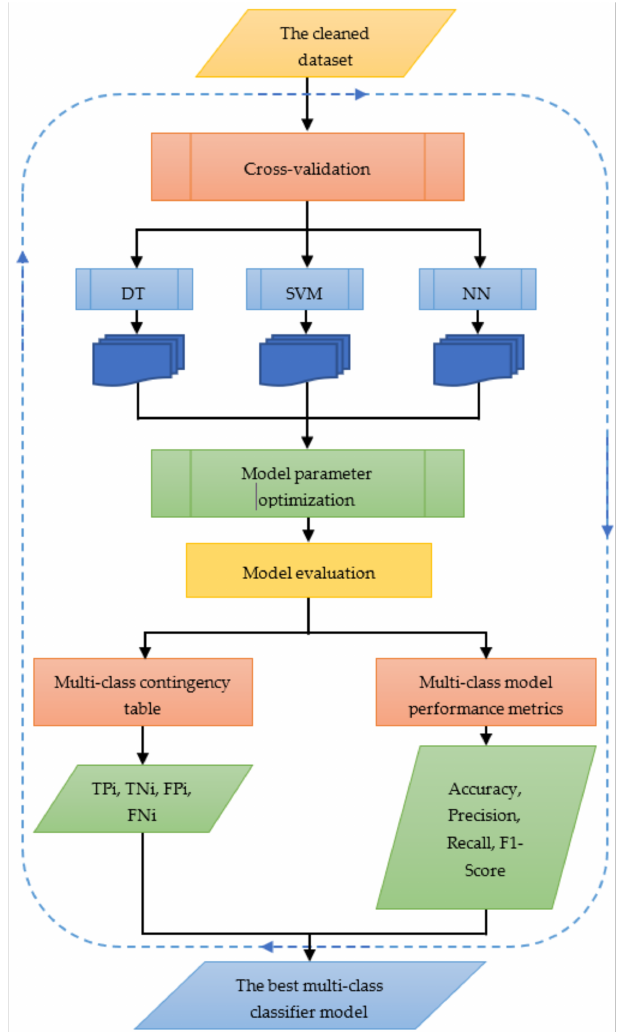
Figure 3. Experimental design of a multiclass classification